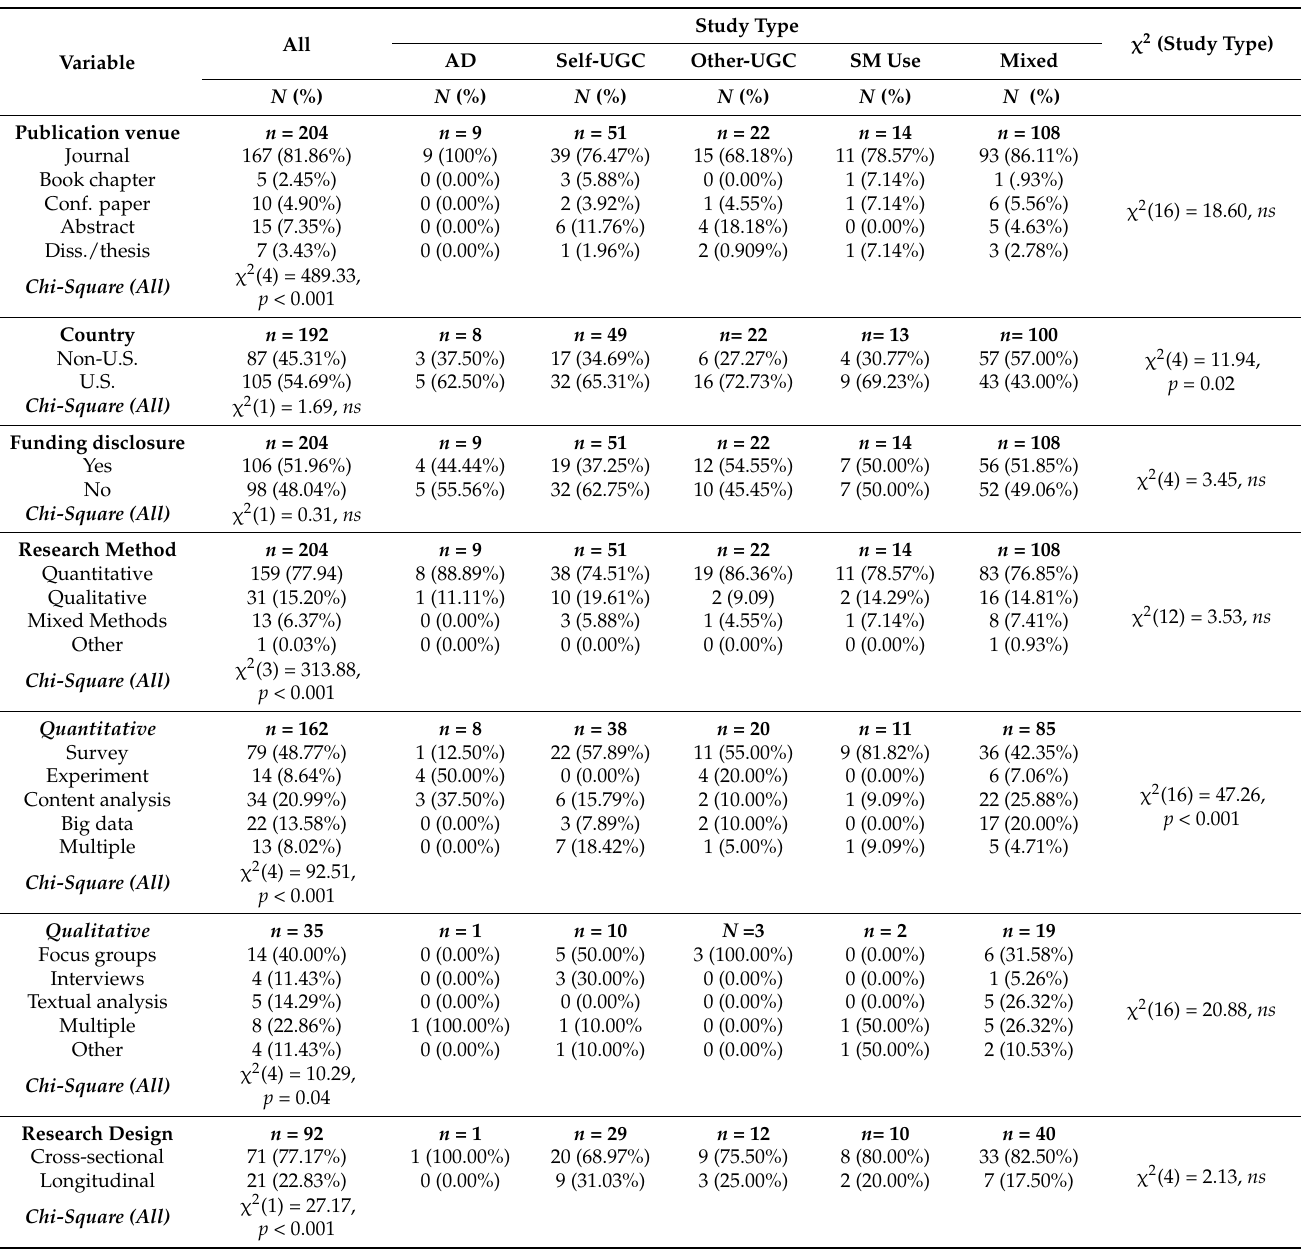
Table 2. Descriptive and Chi-Square results for coded variables and by study